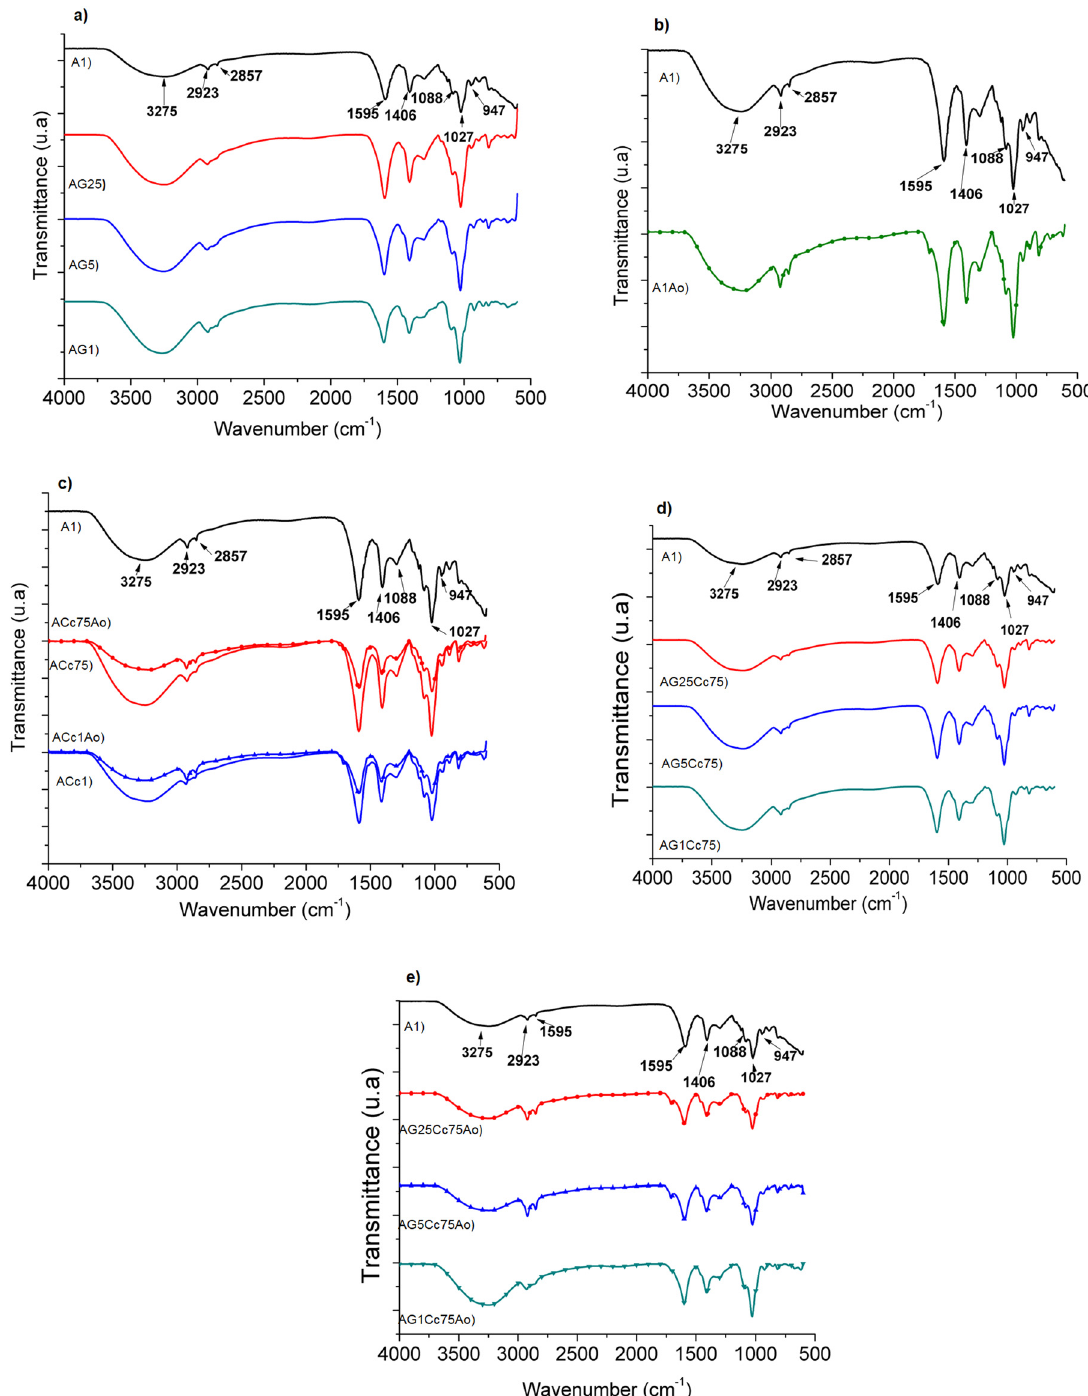
Figure 4: FTIR spectra of alginate fi lms of ( a ) Alginate/glycerol, ( b ) Alginate/oleic acid, ( c ) Alginate/oleic acid/crosslinked, ( d ) Alginate/ glycerol/Crosslinked and ( e ) Alginate/glycerol/oleic